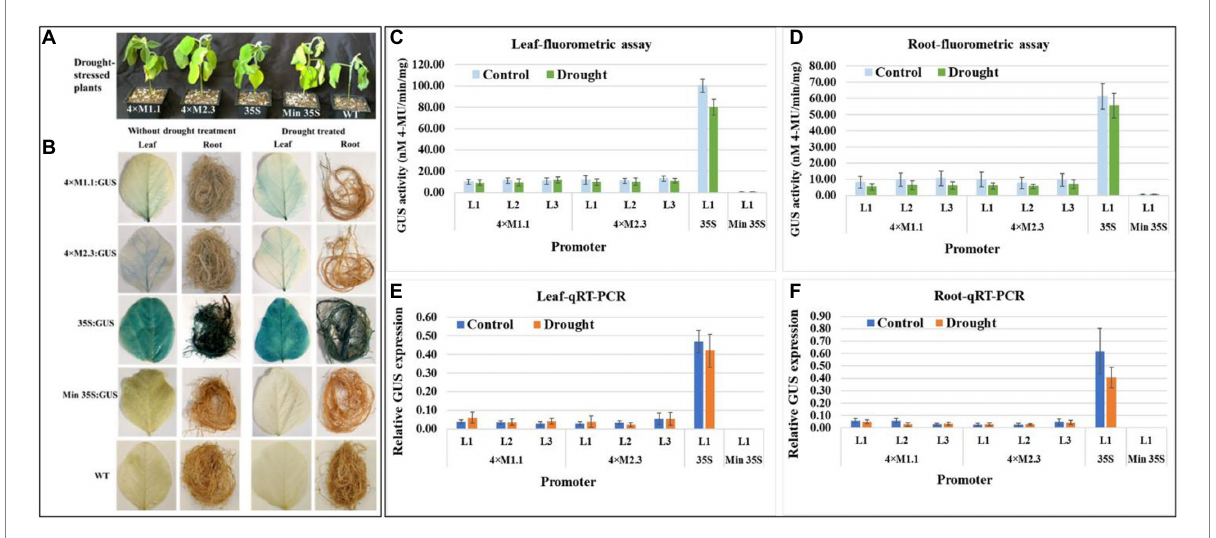
FIGURE 4 GUS activity in leaves and roots of 3-week-old T 3 transgenic soybean containing the individual promoter-GUS construct subjected to the absence (untreated control) and presence (treated) of drought. (A) Representative plants were subjected to dehydration condition via water deprivation for 7 days. (B) Histochemical staining for GUS activity in transgenic soybean and wild-type (WT) plants. (C,D) Fluorometric assay for GUS activity in leaf (C) and root (D) . (E,F) Quantitative real-time RT-PCR (qRT-PCR) analysis for GUS expression in leaf (E) and root (F) . The relative levels of transcripts in qRT-PCR were normalized to soybean ubiquitin gene ( GmUBI 3). Three independent transgenic lines (L1, L2, and L3) were used for 4 × M1.1 and 4 × M2.3 promoter-GUS constructs. One transgenic line (L1) was used for 35S and minimal (Min) 35S promoter-GUS constructs. Bars represent mean values of six biological replicates ± standard error. Statistical analysis by a two-sample paired t -test ( p < 0.05) indicated no significant differences between treated and untreated